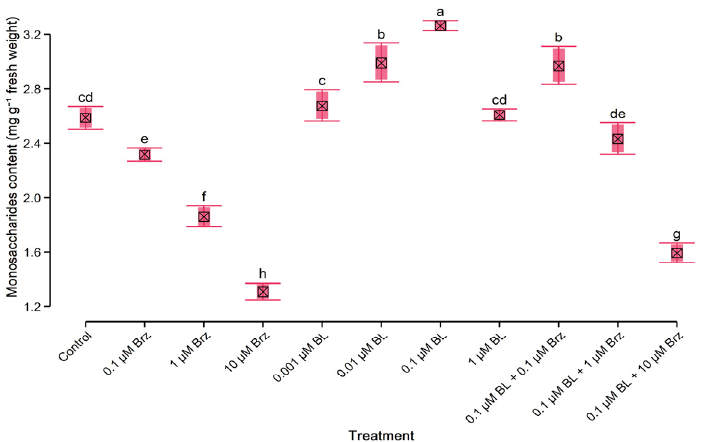
Figure 3. The effect of BL and/or Brz on content of monosaccharides in W. arrhiza after 7 days of cultivation. The crossed square shows the mean ( n = 5). The lower and upper hinges correspond to the lower and upper bounds of 95% confidence interval of the mean. The lower and upper whiskers extend from the hinge to mean ± standard deviation. Means with the same letters are not significantly different ( p ≥ 0.05) according to Tukey’s post hoc test.